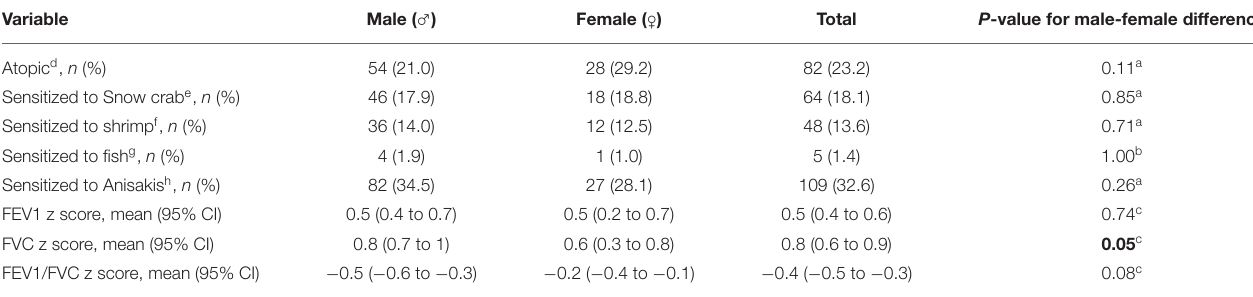
a Pearson Chi 2 -test. b Fisher’s exact test.